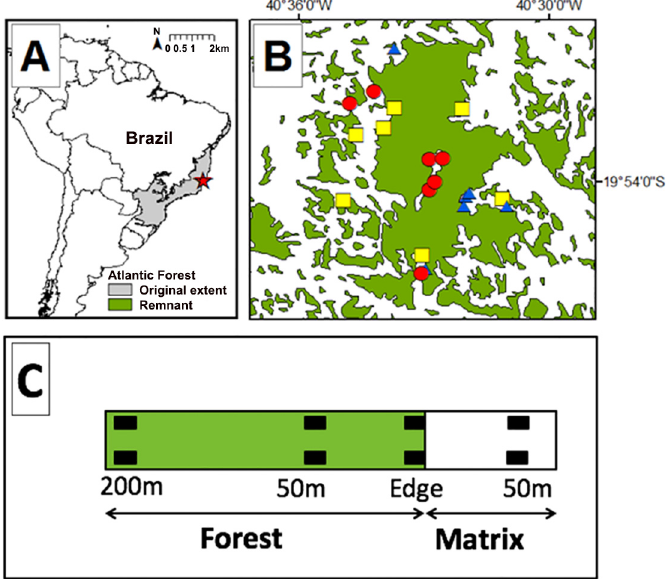
Fig 1. Study sites and sampling design. (A) Location of Santa Teresa municipality in the original extent of Brazil ’ s Atlantic Forest, (B) 21 sampled sites, adjacent to abandoned pasture (red circle), coffee plantation (blue triangle), and Eucalyptus plantation (yellow square), located within and around a biological reserve, and (C) sampling design showing a 250 m transect with paired plots (black square) by distance from the forest